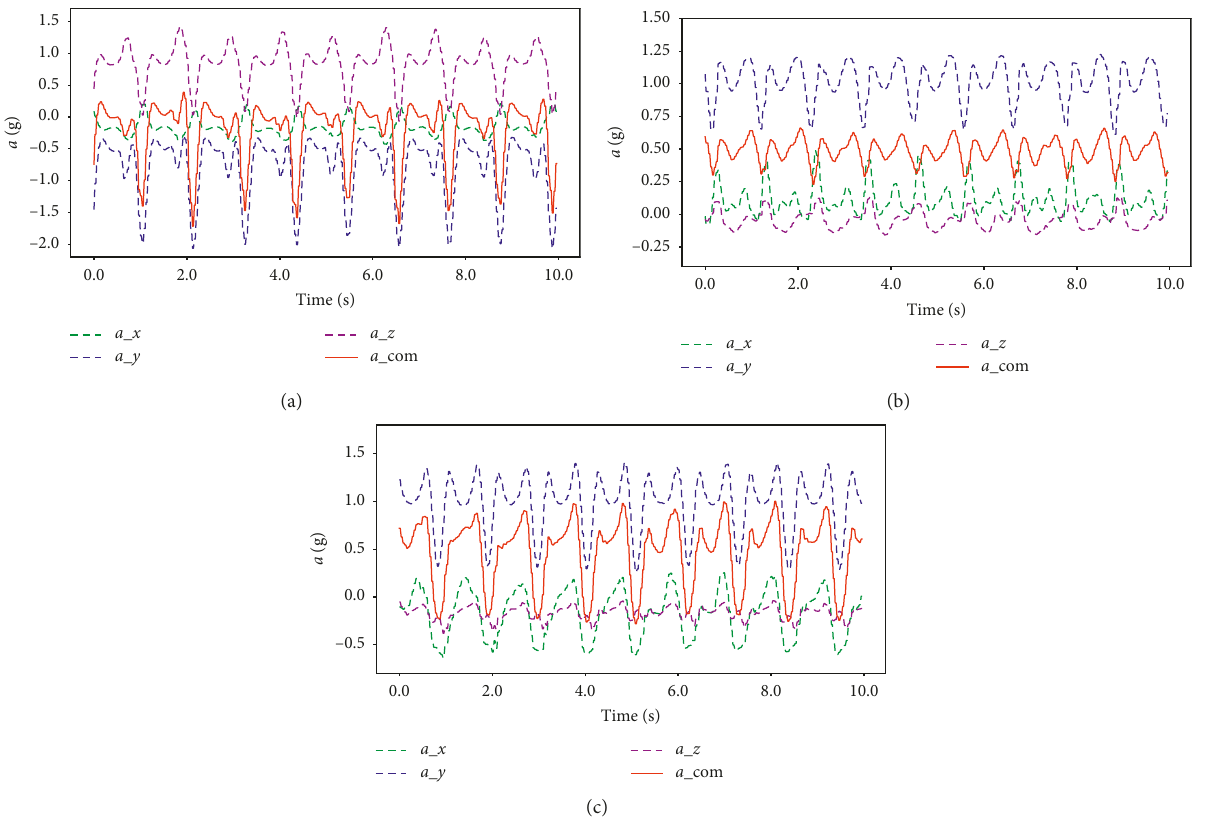
Figure 3: Acceleration data collected under the three body parts: foot (a), thigh (b), and calf (c). a _ x represents the acceleration in the x -axis direction, a _ y represents the acceleration in the y -axis direction, a _ z represents the acceleration in the z -axis direction, and a _com represents the combined